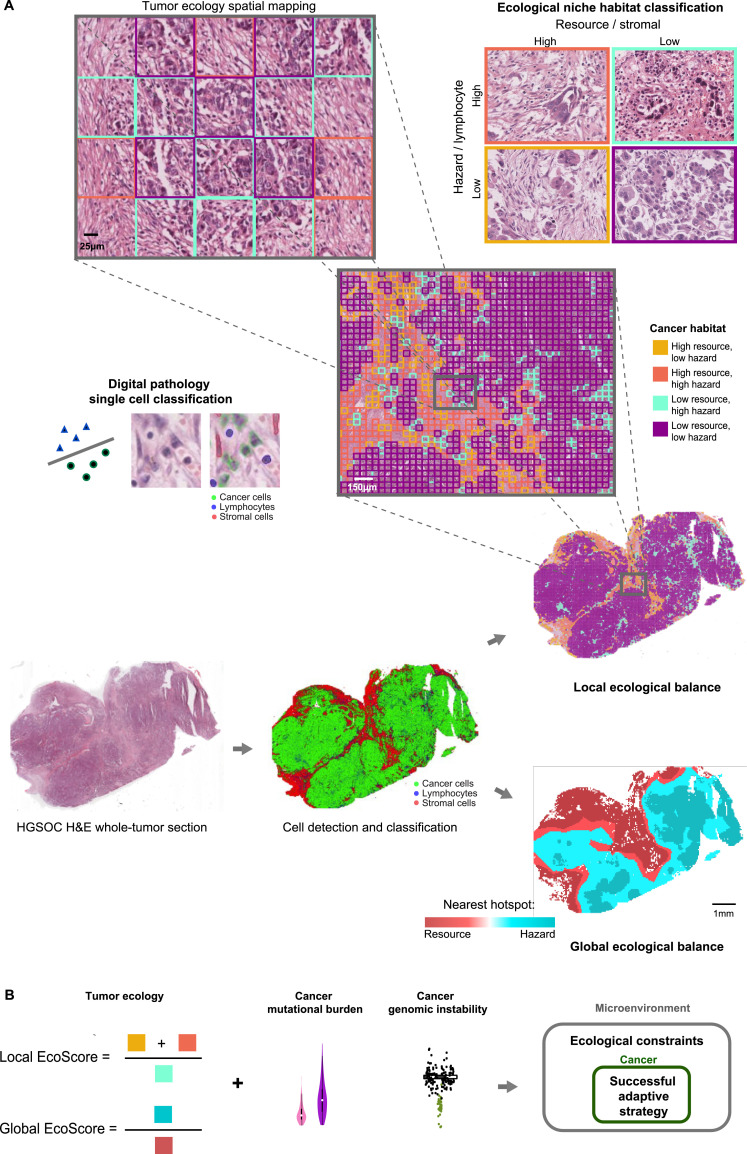
An ecological resource-hazard characterization of high-grade serous ovarian carcinoma (HGSOC). (A) Our H&E image analysis pipeline, based on 104 quantitative measures of cell nucleus texture and morphology to classify nuclei into cancer, lymphocyte and stromal cell nuclei and provides their spatial coordinates, is used to process an H&E-stained ovary tumour sample (left) and map the distribution of the three cell types (middle). The sample is then divided into small regions using a grid of square size 100 μm. The abundance of lymphocytes and stromal cells is evaluated in each square that contains at least one cancer cell to determine its local ecological habitat type. Spatial distributions of the four habitats in this tumour are shown in a heatmap (right, top) with colours corresponding to the example habitat images above. Also shown is the grid-based habitat classification in one region of the tumour sample. In addition, hotspot analysis is performed to detect spatial clustering in lymphocytes and stromal cells in each sample. The distances to the nearest lymphocyte and stromal hotspots are evaluated for every habitat type and indicated in the heatmap (right, bottom). This is used to determine the global ecological balance in a tumour Based on previous findings, we propose that stromal cells act as ‘resources’ for cancer while lymphocytes present a predatory ‘hazard’. (B) The local EcoScore is computed as the balance between tumour-promoting and tumour-inhibiting habitats, and the global EcoScore is the ratio of the mean distances to the nearest lymphocyte and stromal cell hotspots for a habitat in the sample. Together with genomic tumour analyses, we present an integrated characterization of HGSOC.